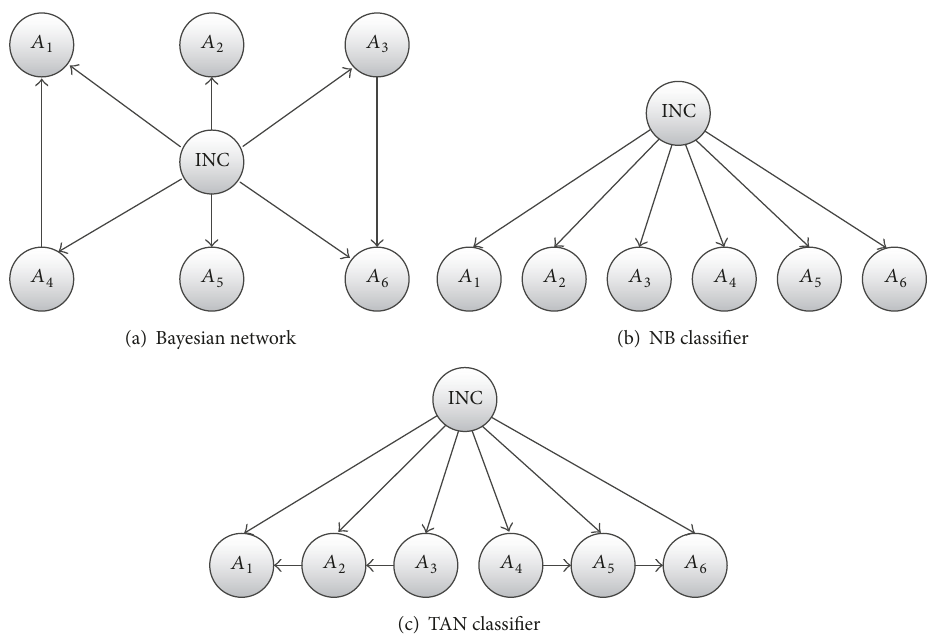
Figure 1: Typical structures of Bayesian network, NB classifier, and TAN classifier for incident